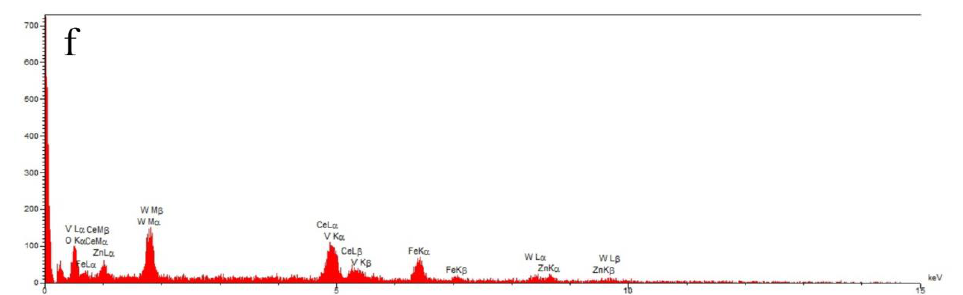
Figure 2. SEM images of ( a ) Fe 3 O 4 / ZnWO 4 (S 1 ), and Fe 3 O 4 / ZnWO 4 / CeVO 4 with the molar ratios of ( b )